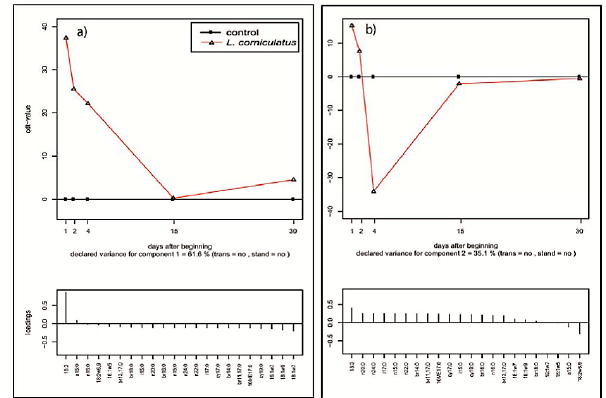
Fig. 3. First (a) and second (b) component of the PRC calculation on the basis of the mol% data of all individual PLFA relative to total PLFA of L. corniculatus treatments compared to the control treatment throughout the experimental period of 30weeks ( n =